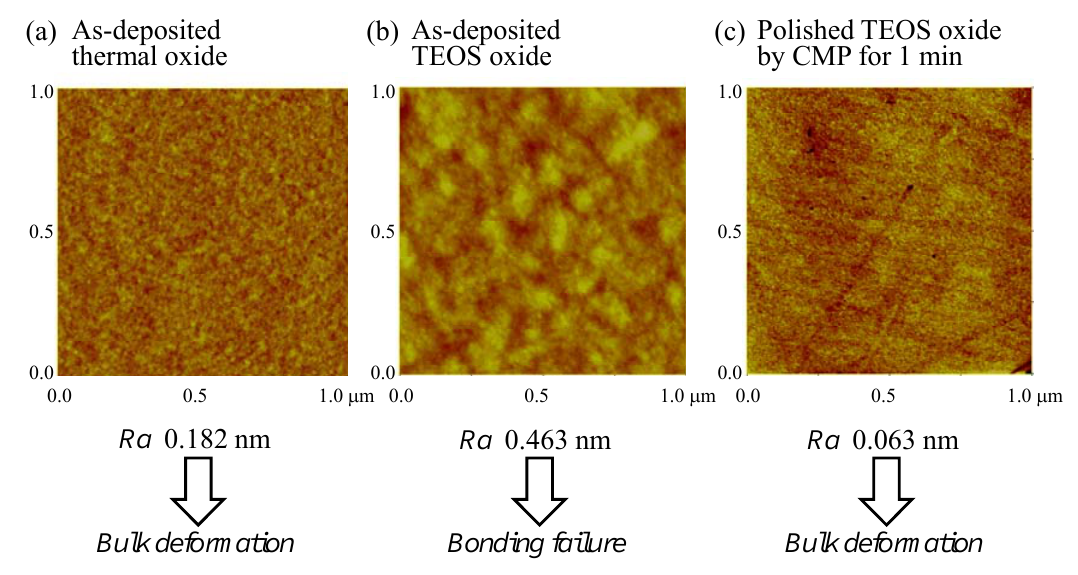
Figure 12. AFM images of bonding regions on the back surface of chips having cavity structures.